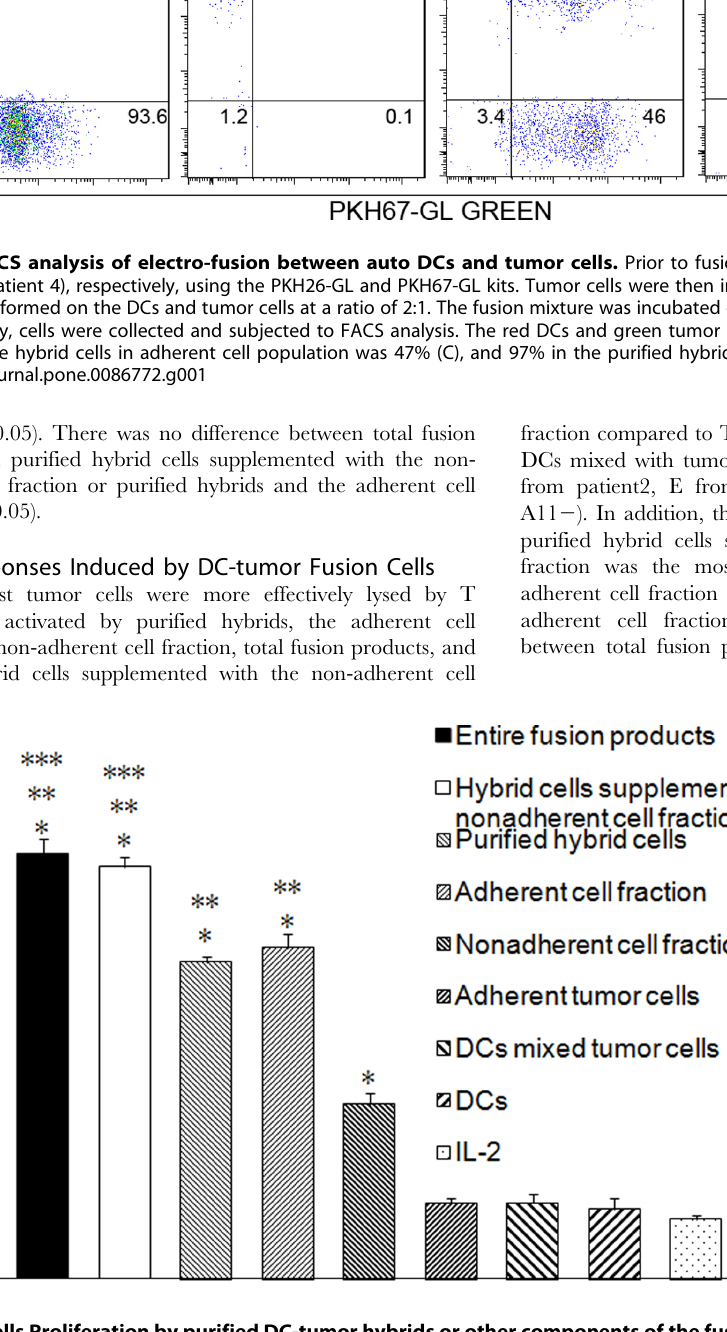
Figure 2. T cells Proliferation by purified DC-tumor hybrids or other components of the fusion products. Non-adherent PBMCs from the same patient (from patient1) were purified using nylon wool to remove antigen-presenting cells and B cells. They were incubated with purified hybrid cells, adherent tumor cells, the non-adherent cell fraction, the adherent cell fraction, purified hybrid cells supplemented with non-adherent cell fraction, total fusion products, DCs mixed with tumor cells, or DCs at a ratio of 10:1 in the presence of 20 units/ml human IL-2. T cells cultured in the presence of 20 units/ml human IL-2 were used as a control. T cell proliferation was determined using the standard [ 3 H] thymidine uptake assay. Columns , mean values of triplicate samples; bars , SD. * P , 0.05 for T cell proliferation stimulated by purified hybrids, the adherent cell fraction, the non-adherent cell fraction, total fusion products or purified hybrid cells supplemented with the non-adherent cell fraction compared with adherent tumor cells, DCs mixed with tumor cells, DCs, or IL-2 alone. ** P , 0.05 for T cell proliferation stimulated by the total fusion products, purified hybrid cells supplemented with the non-adherent cell fraction, purified hybrid cells or the adherent cell fraction compared with the non-adherent cell fraction. *** P , 0.05 for T cell proliferation stimulated by the total fusion products or purified hybrid cells supplemented with the non-adherent cell fraction compared to purified hybrid cells or the adherent cell fraction. There was no difference between the total fusion products and purified hybrid cells supplemented with the non-adherent cell fraction or between purified hybrids and the adherent cell fraction ( P . 0.05).